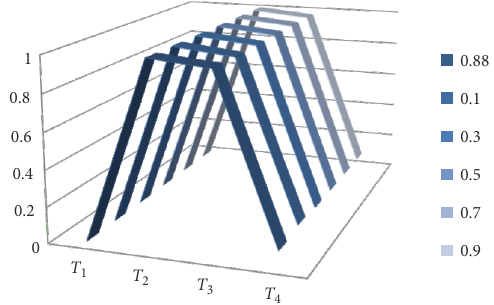
Figure 4. When parameter h changes alone, the results of ℑ ( T k ) in different h